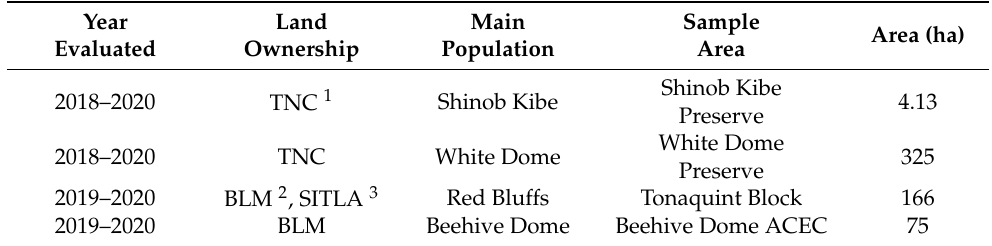
Table 1. Study site information for pollen addition experiment in 2018 and reproductive output studies in 2019 and 2020. See [16] for further location